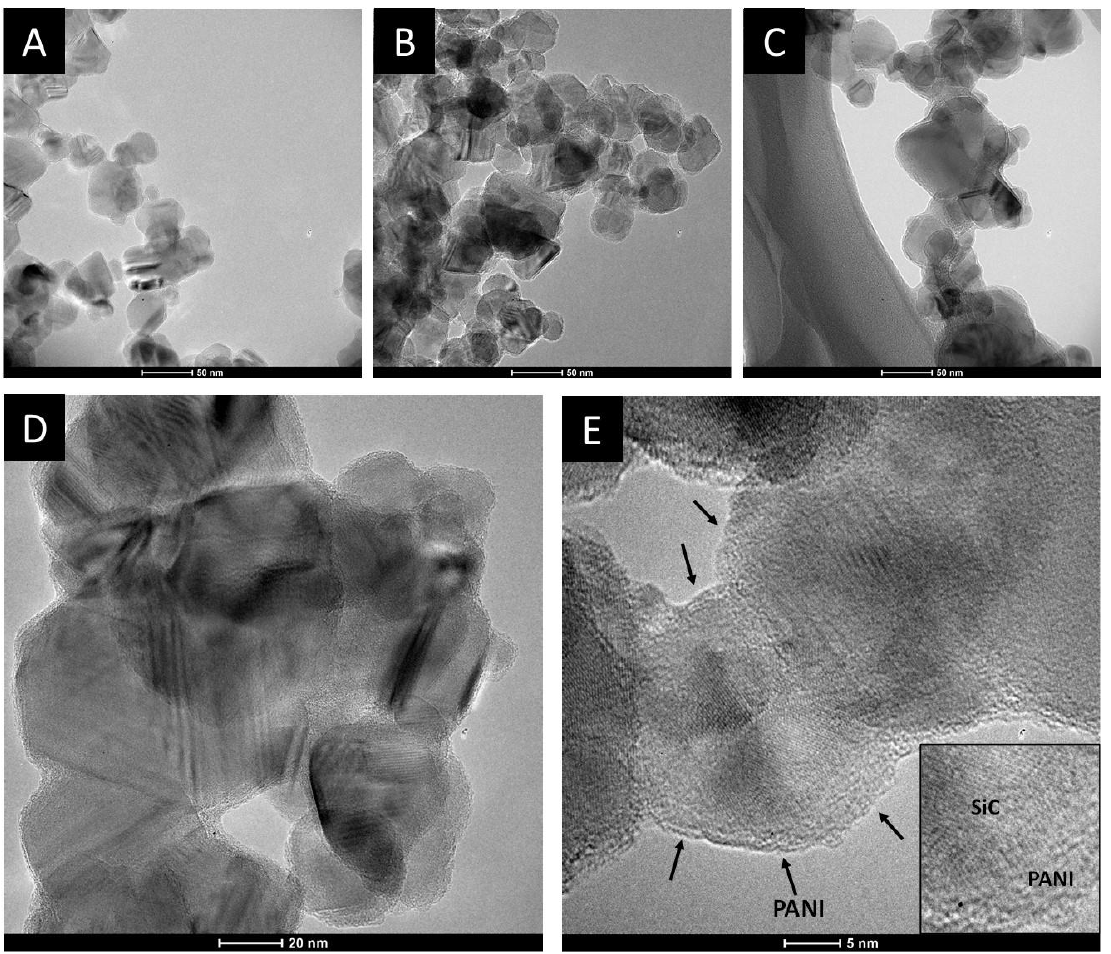
Figure 6. Transmission electron microscopy (TEM) images, captured for ( A ) SiC; ( B ) SiC/PANI, after 5 min of illumination; ( C ) SiC/PANI, after 60 min of illumination at 130,000x magnification; HR-TEM images taken for the SiC/PANI nanocomposite synthesized with 60 min of irradiation. The magnifications were ( D ) 255,000x; and ( E ) 530,000x, respectively.